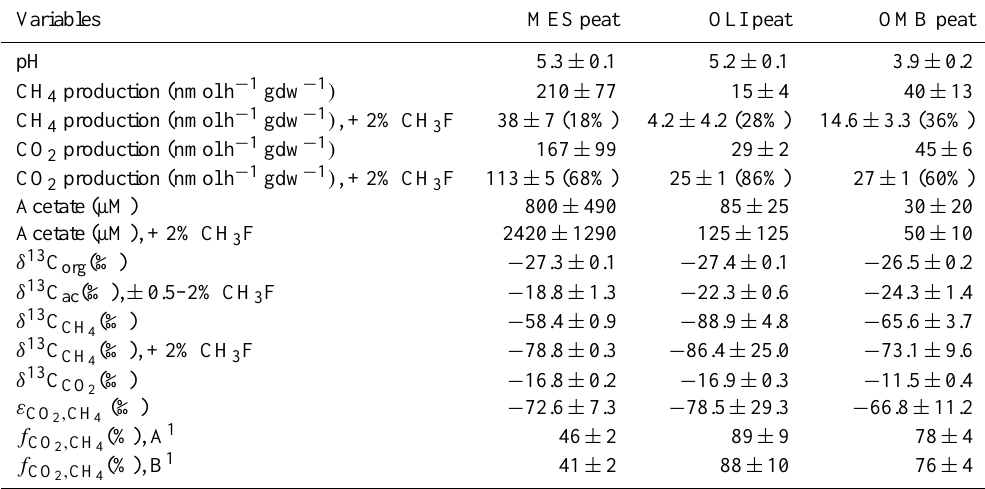
Table 1. Production rates of CH 4 and CO 2 , concentrations of acetate, values of δ 13 C, isotopic enrichment factors and fractions of CH 4 produced from CO 2 in samples from different boreal peatland ecosystems, i.e., mesotrophic fen (MES), oligotrophic fen (OLI), and om- brotrophic bog